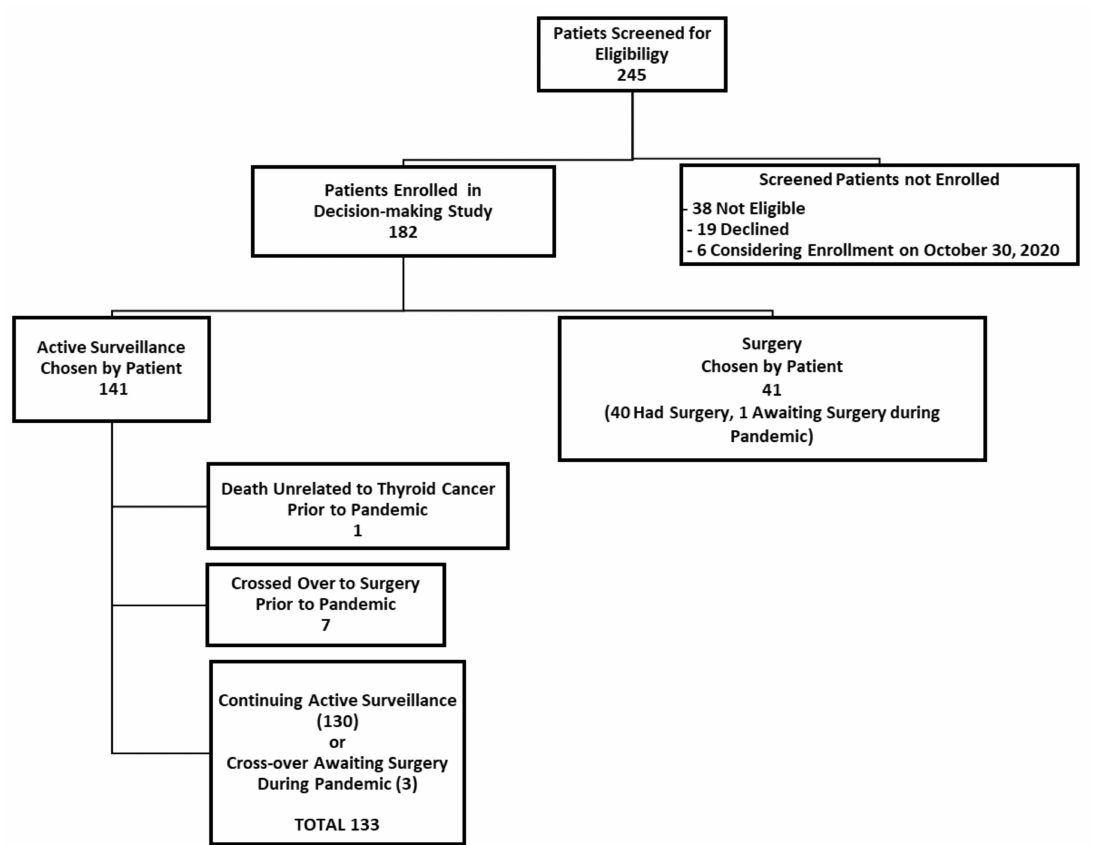
Figure 1. Participant flow